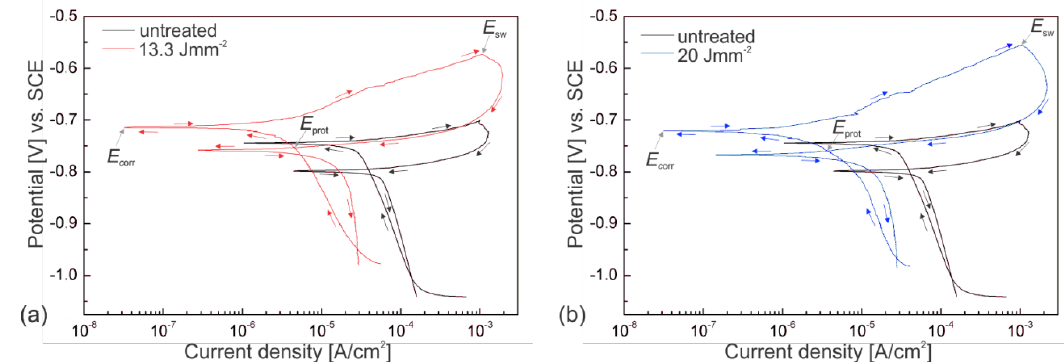
Figure 9. Cyclic polarization (CP) curves in 0.5 M NaCl solution of untreated/substrate and laser processed samples with ( a ) 13.3 J/mm 2 and ( b ) 20 J/mm 2